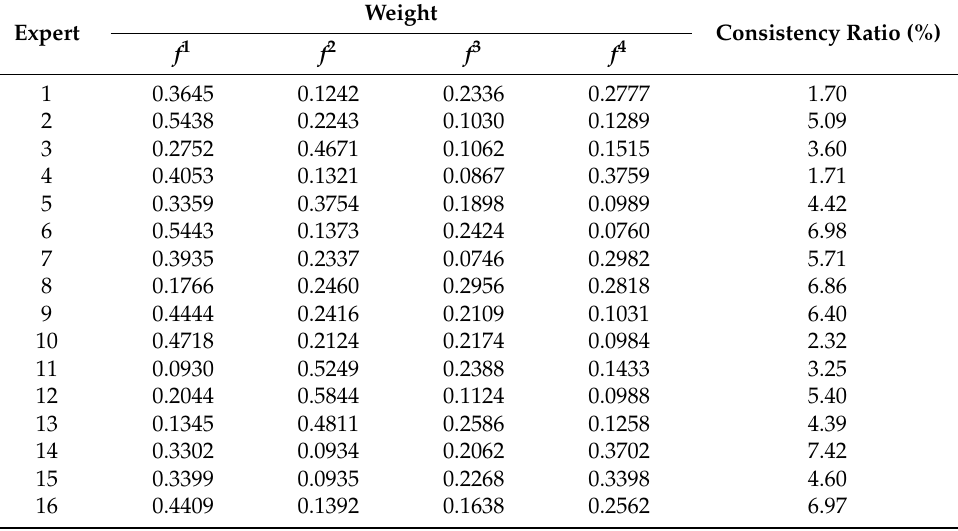
Table 9. Objective function